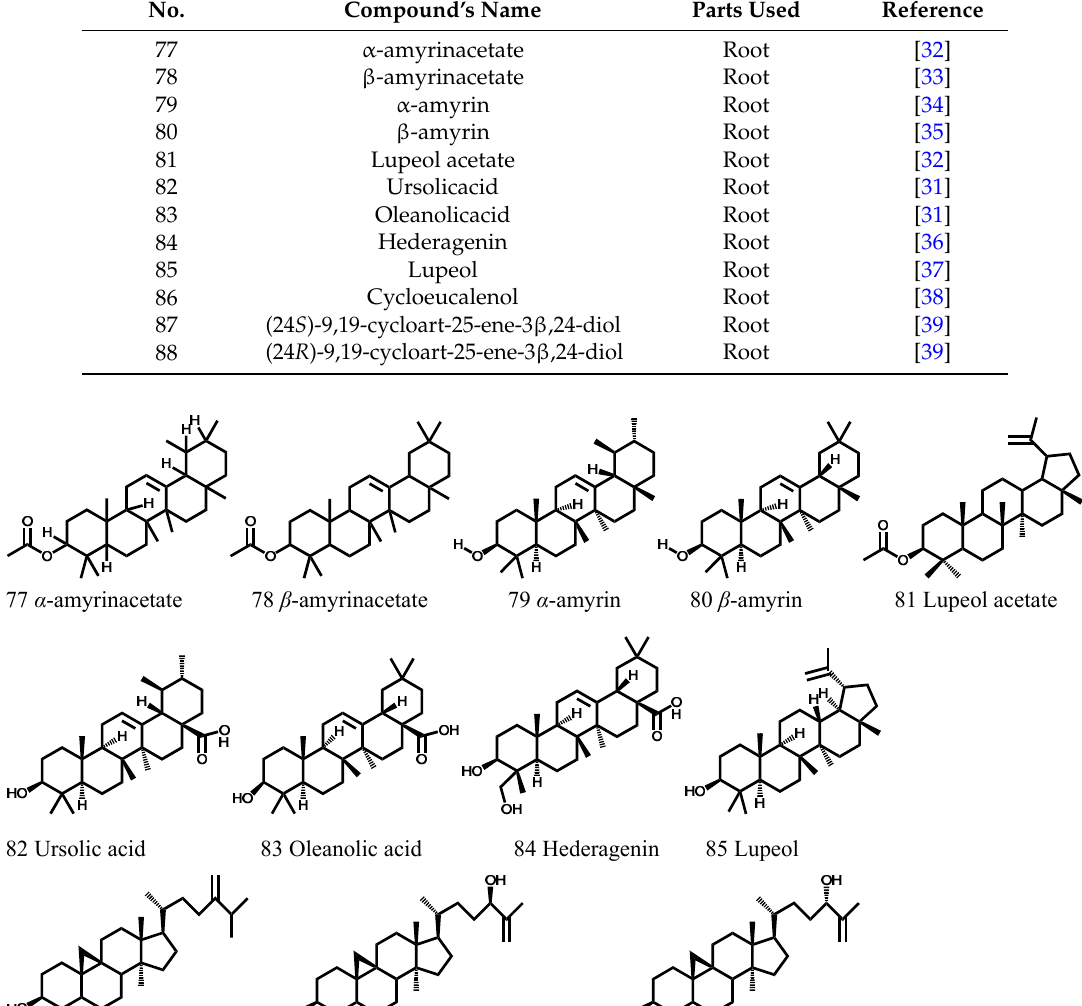
Table 4. Terpenoids from Cortex Periplocae (77–88).